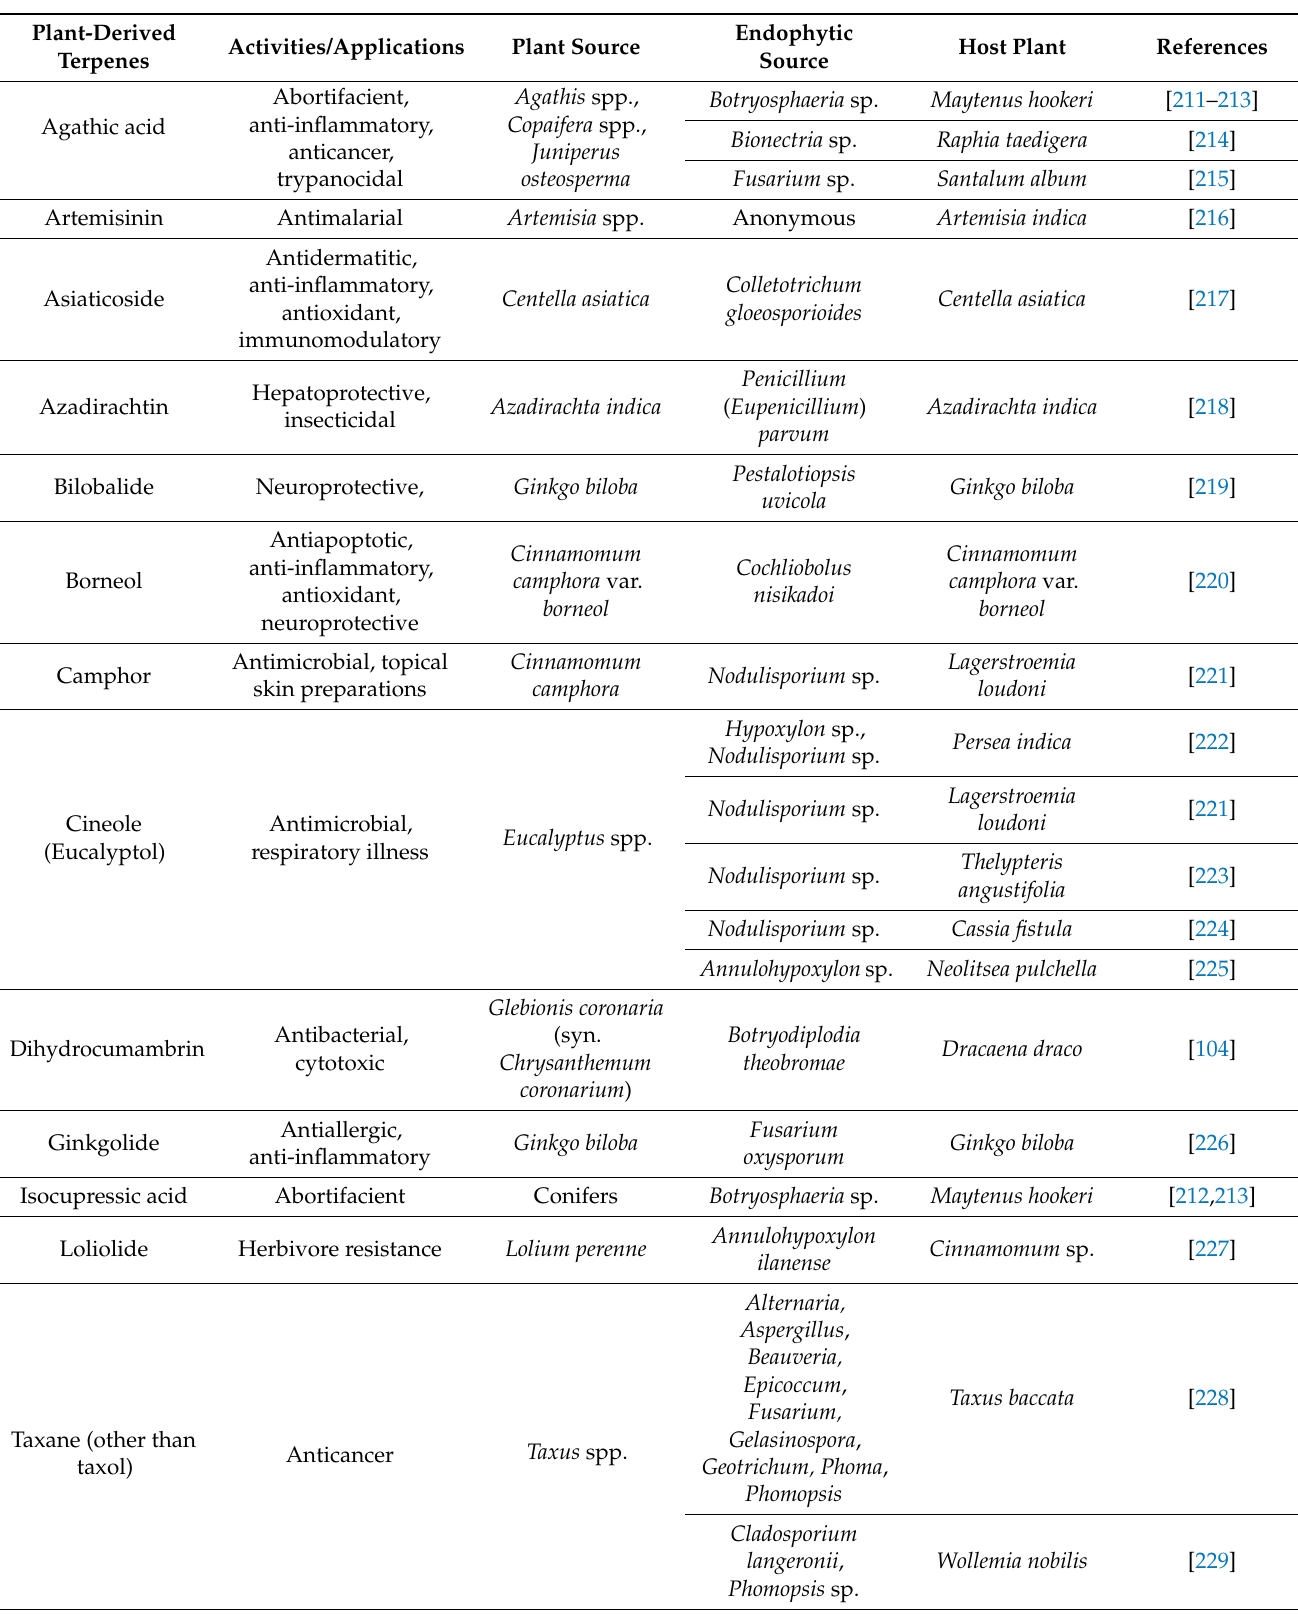
Table 6. Plant-derived terpenes produced by endophytic